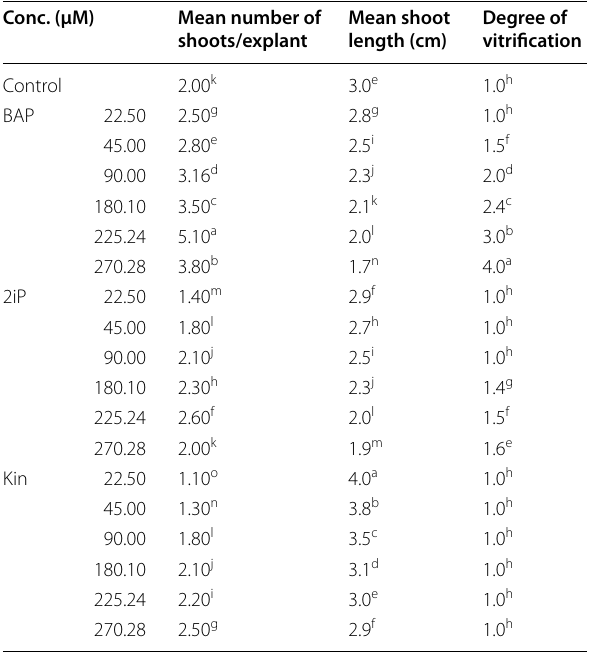
Table 2 Effect of BAP, 2iP and Kin on L. barbarum growth